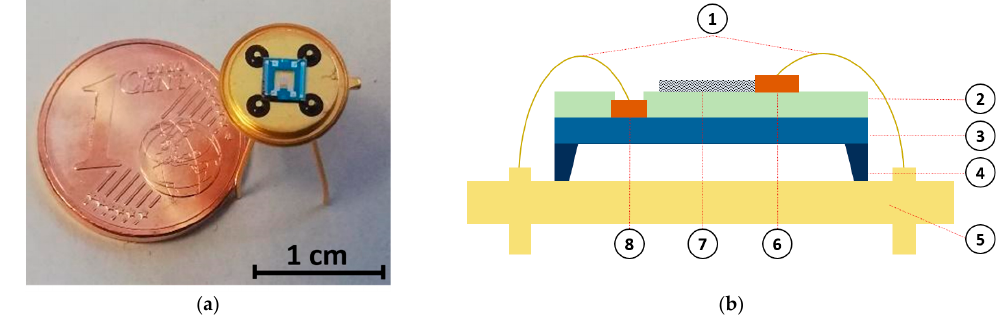
Figure 1. Single-walled carbon nanotube (SWCNT)-based chemiresistive gas sensor. ( a ) Photograph image of the final device. ( b ) Device schematic showing the different layers composing the device: (1) electrical connections, (2) inter-metal dielectric, (3) SiO 2 /Si 3 N 4 /SiO 2 (silicon dioxide–silicon ni- tride–silicon dioxide) membrane, (4) bulk silicon, (5) TO-39 holder, (6) Ti/Pt electrodes, (7) sensing material (SWCNT), and (8) Ti/Pt heater.